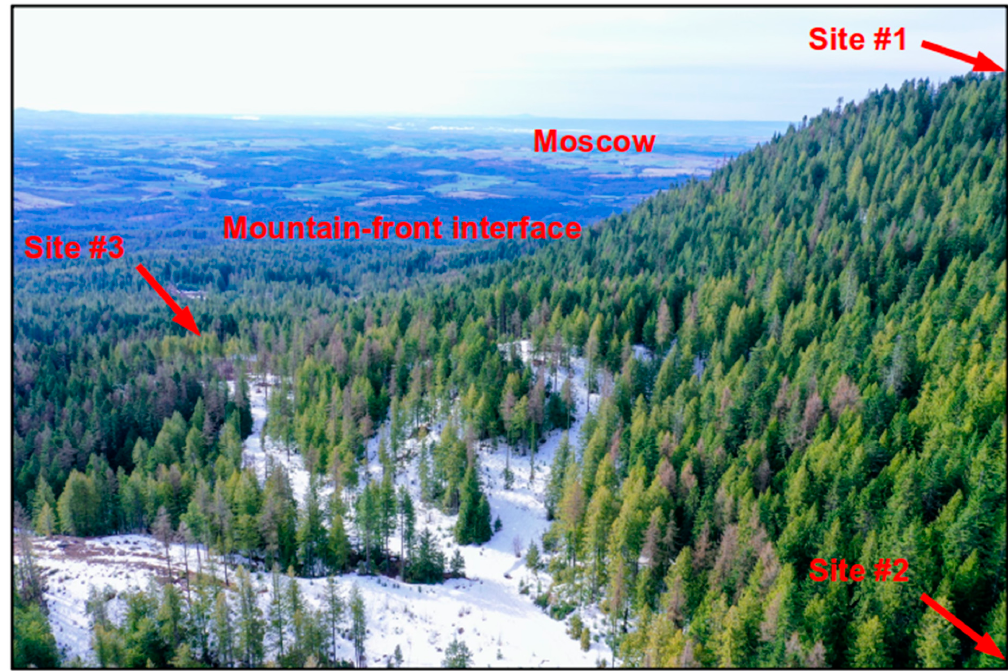
Figure 6. Snow/snowmelt collection locations along the eastern Palouse Range from a drone view looking towards Moscow, Idaho. The mountain-front interface is indicated along the lower slope where the forest transitions to farmland and represents the primary recharge zone.